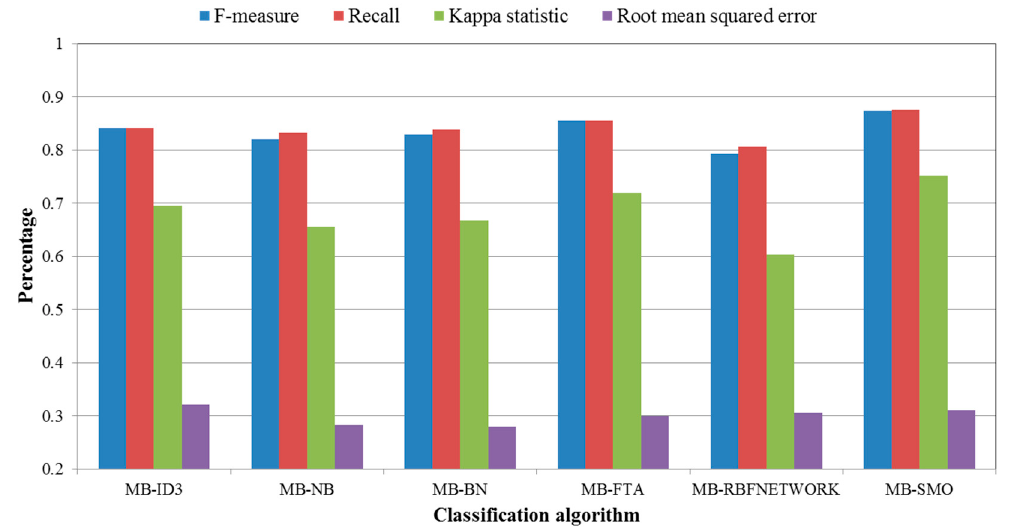
Figure 11. The statistical analysis of the classification.